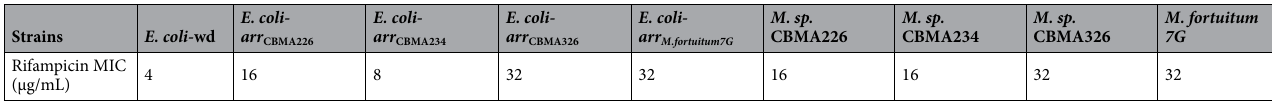
Table 2. E-test MIC values for rifampicin in E. coli and wild